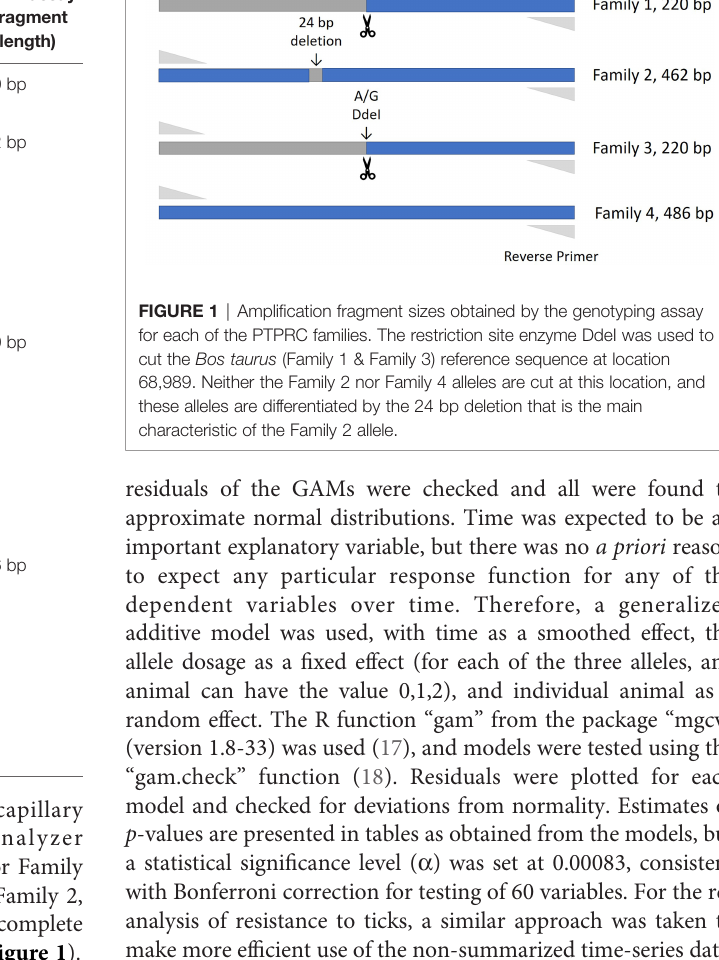
TABLE 3 | Major discriminating features of nucleotide sequence used for de fi ning the four distinct PTPRC families. Family